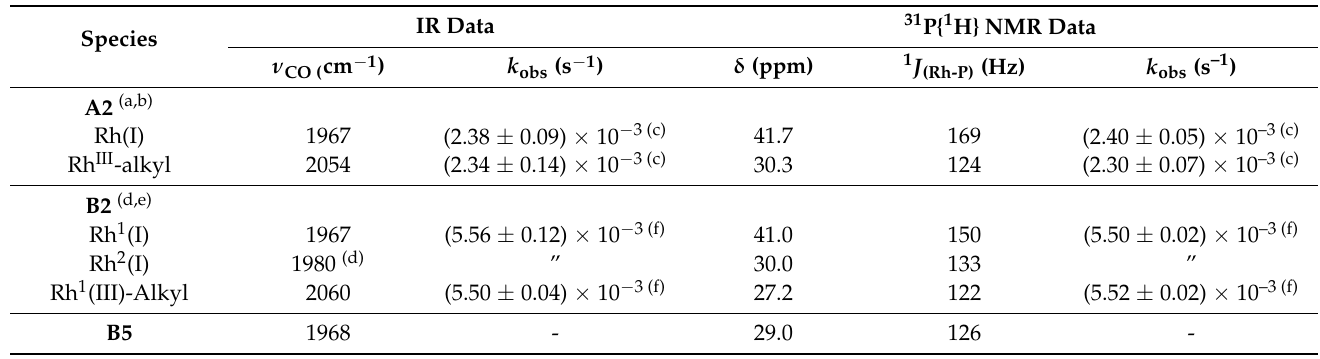
Table 4. Summary of chemical shifts, coupling constants, and preliminary kinetic data in dichloromethane for the oxidative addition of iodomethane to [Rh(Indoli)(CO)(PPh 3 )] ( A2 )